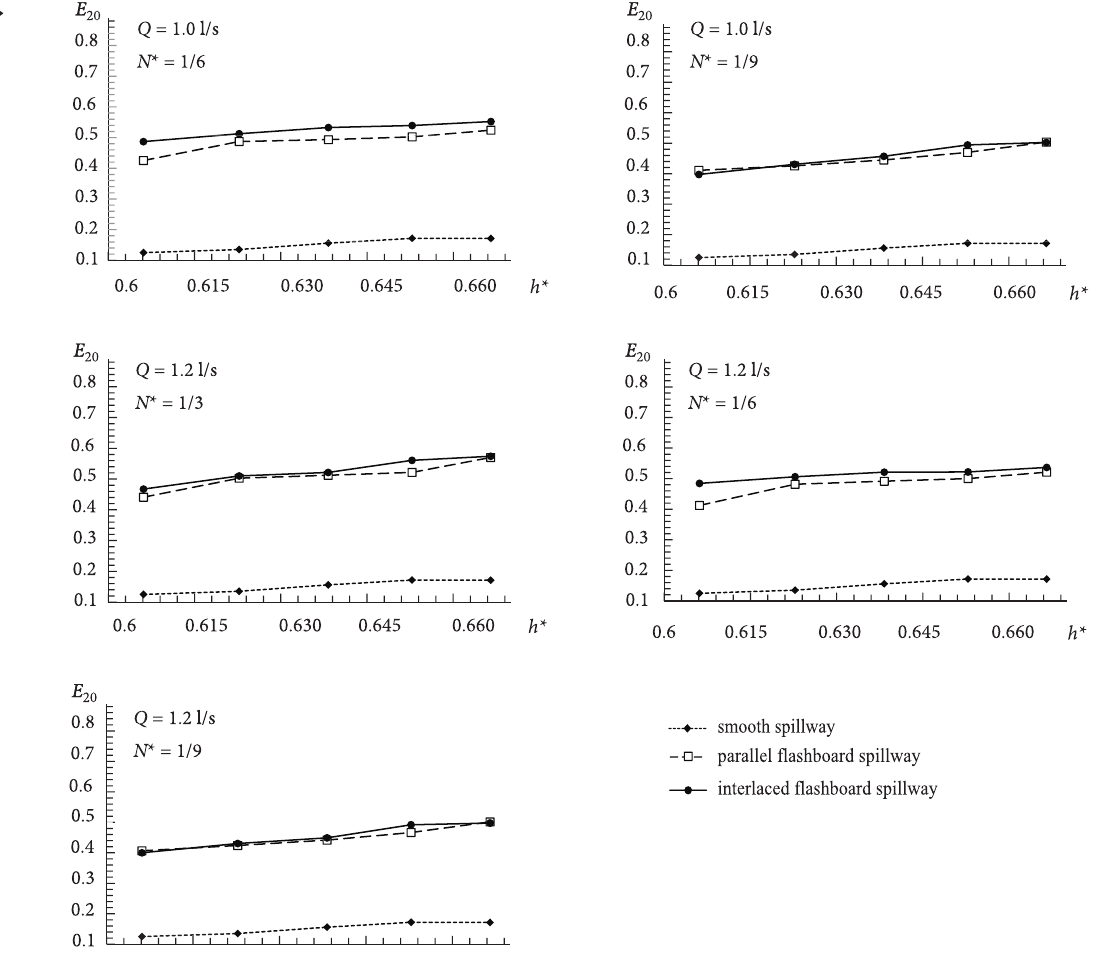
Fig. 7. Comparison between E